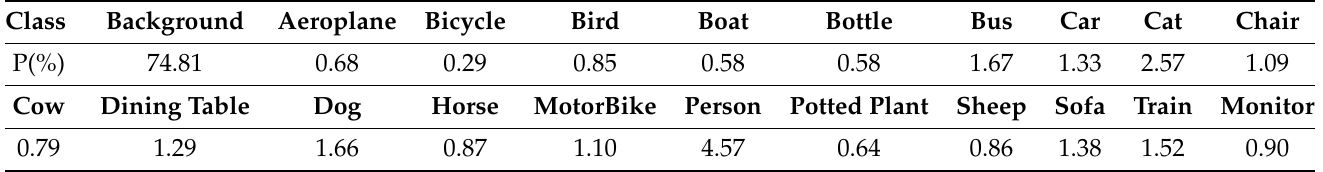
Table 2. of 21 categories (with background) on the PASCAL VOC 2012 [19] training